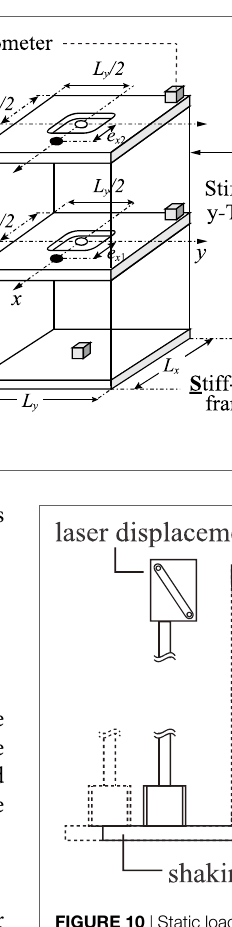
FIGURE 10 | Static loading